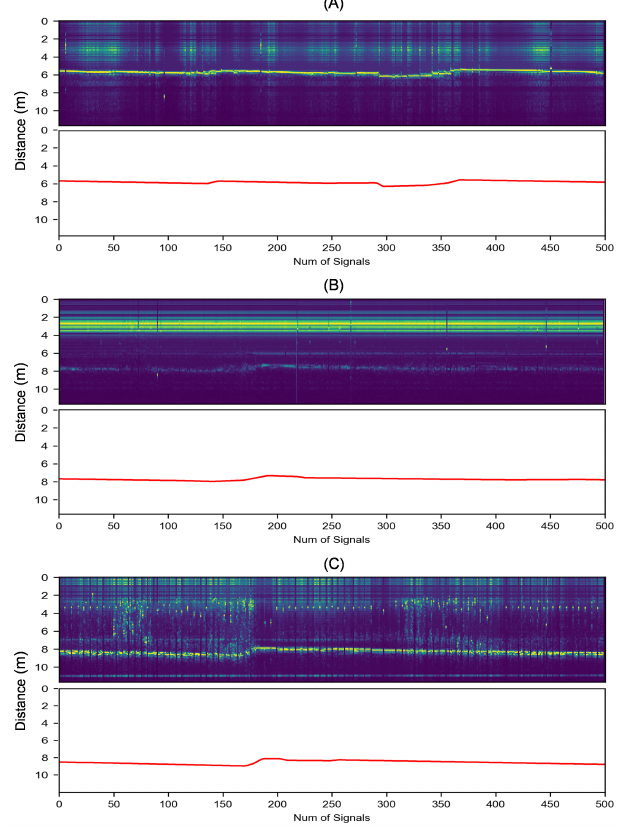
Figure 3. The time–frequency spectrum and the expectation stockline of different radar signals. ( A – C ) are from radar #2, #4, and #6, respectively. The horizontal axis represents the number of time series signals, and the vertical axis represents the distance between the radar sensor and the measured